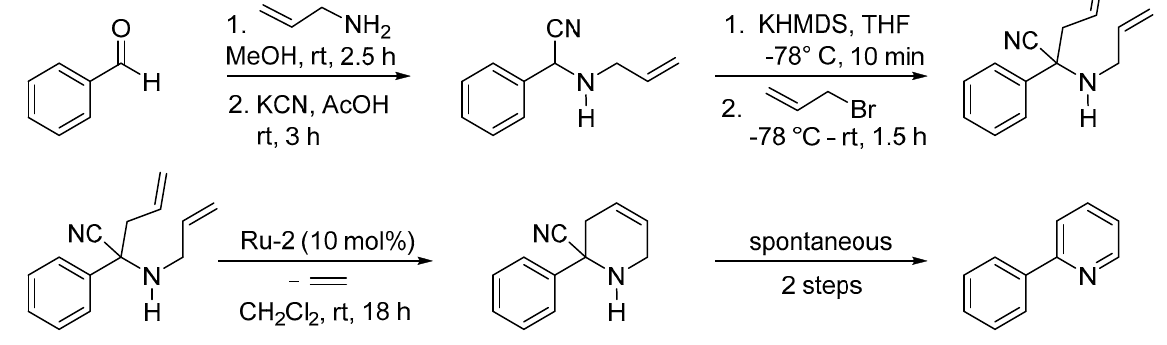
OMe Figure 3. Scope of pyridoindoles synthesized via RCM/aromatization sequence. The optimized reaction sequence was employed in the synthesis of dimeric pyri- doindoles (Scheme 28) Scheme 28. Synthesis of dimeric pyridoindoles.